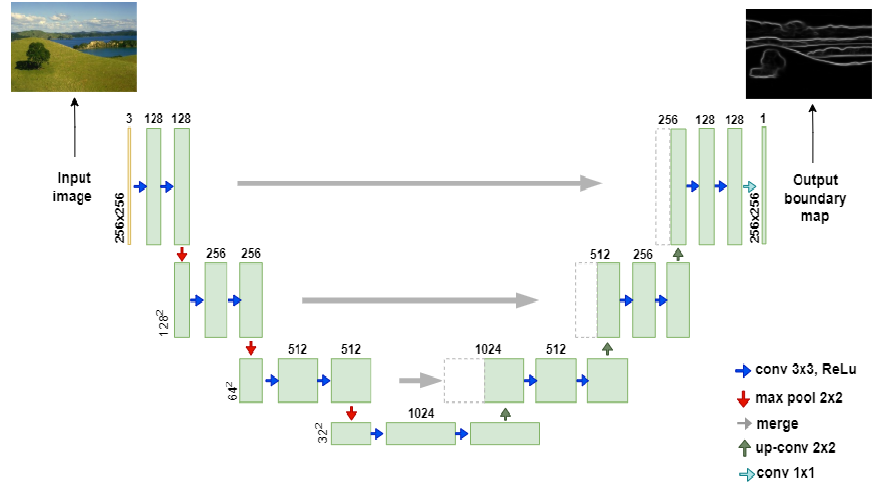
Figure 2. Convolutional neural network (CNN) based on customised U-Net architecture.